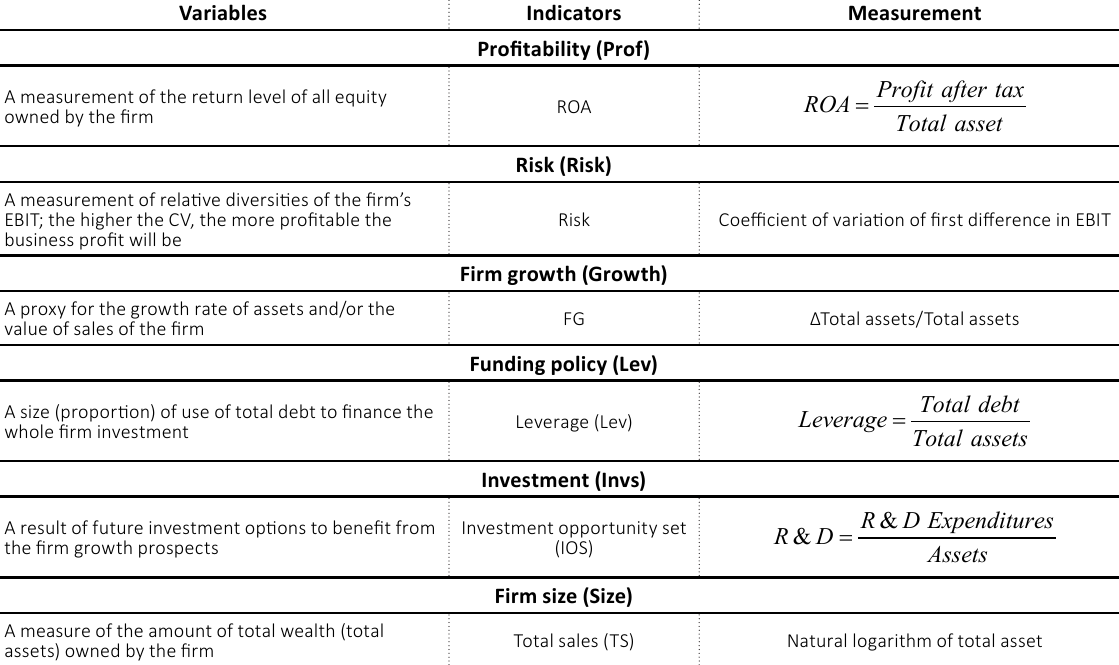
Table 1. Operational variable